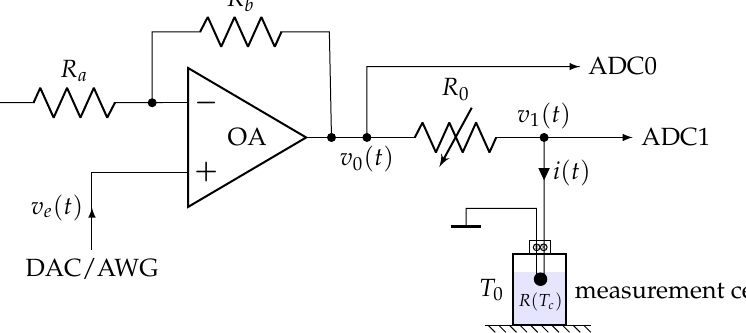
Figure 4. Amplified divider bridge circuit used both to control the self-heating of the NTC bead-type thermistor and measure the time variations of its electrical resistance R ( T c ) . This circuit can be used in both transient and frequency modes. ADC0 and ADC1 are two inputs of an Analog to Digital Converter (ADC). The circuit can be excited either by using a Digital To Analog Converter (DAC) or by using an Arbitrary Waveforms Generator